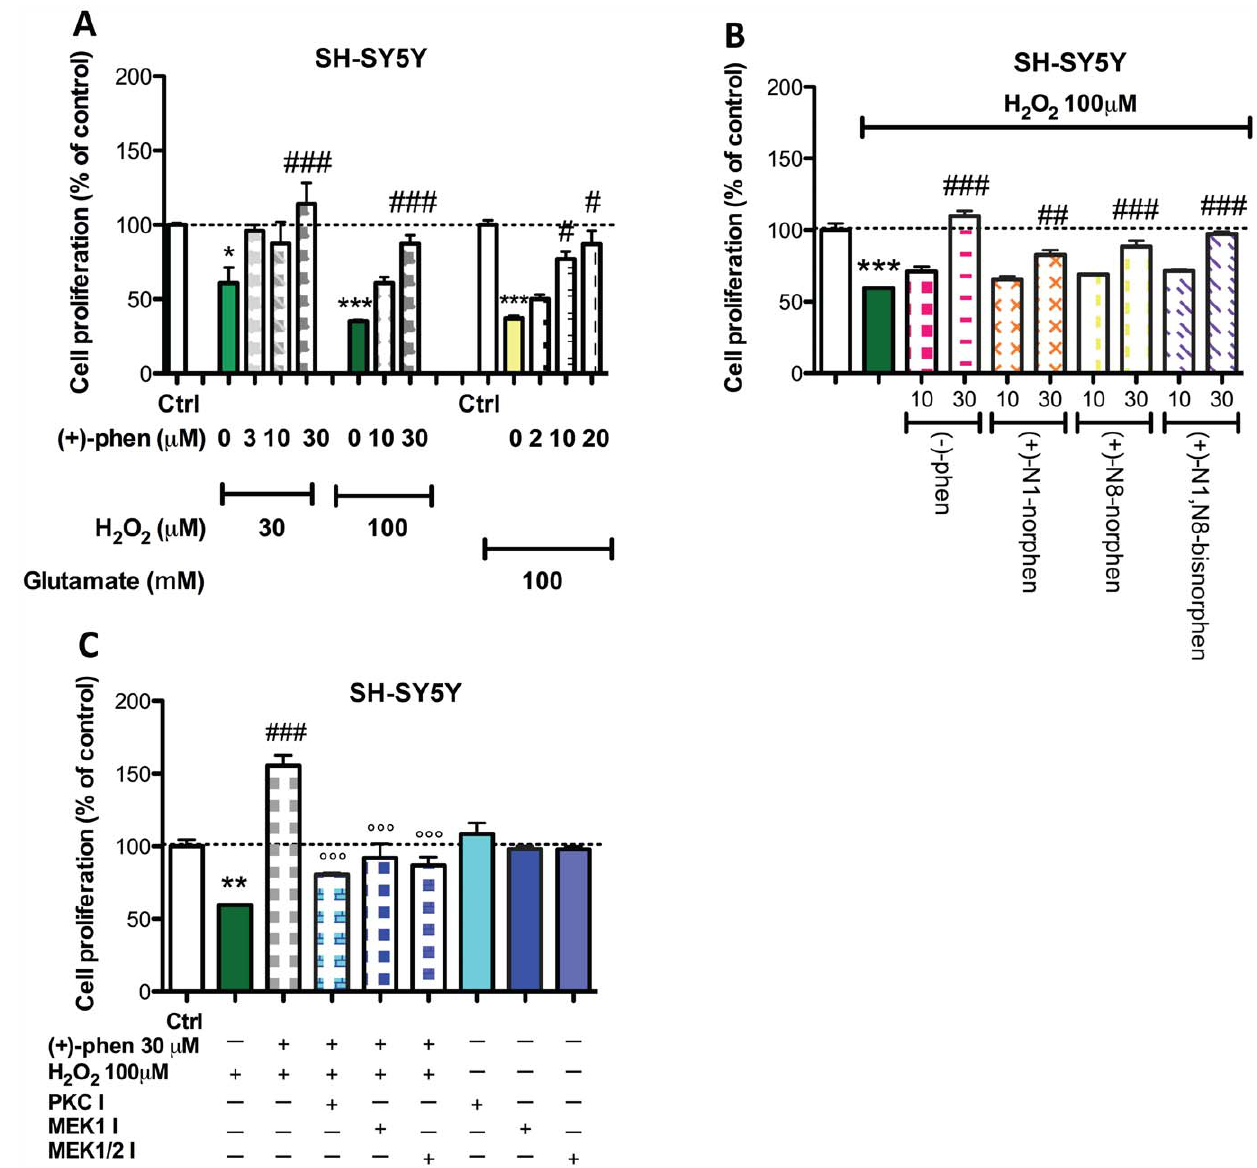
Figure 3. Phenserine and primary metabolites exert neuroprotective actions against H 2 O 2 and glutamate-induced toxicity in SH- SY5Y cells. Cells were exposed to 3, 10 or 30 m M ( + )-phenserine 24 hr before addition of 30–100 m M H 2 O 2 or to 100 mM glutamate in (A), or to ( 2 )- phenserine, ( + )-N1-norphenserine, ( + )-N8-norphenserine or ( + )-N1,N8-bisnorphenserine 24 hr before addition of 100 m M H 2 O 2 in (B). In (C), inhibitors of PKC (GF109203X, 2.5 m M), MEK1/2 (U0126, 5 m M) or MEK1 (PD98059, 10 m M) were added to the cells 30 min before adding 30 m M ( + )-phenserine. 100 m M H 2 O 2 was added after 24 hr and after additional 24 hr incubation, cell proliferation was determined by MTS assay. *P , 0.05 **p , 0.01, and ***p , 0.001 compared to control samples without drug, # p , 0.05, ## p , 0.01 and ### p , 0.001 compared to samples with ( + )-phenserine only, uuu compared to samples exposed to ( + )-phenserine and H 2 O 2 (one-way ANOVA followed by Bonferronis multiple comparison post hoc test). Results are expressed as mean 6